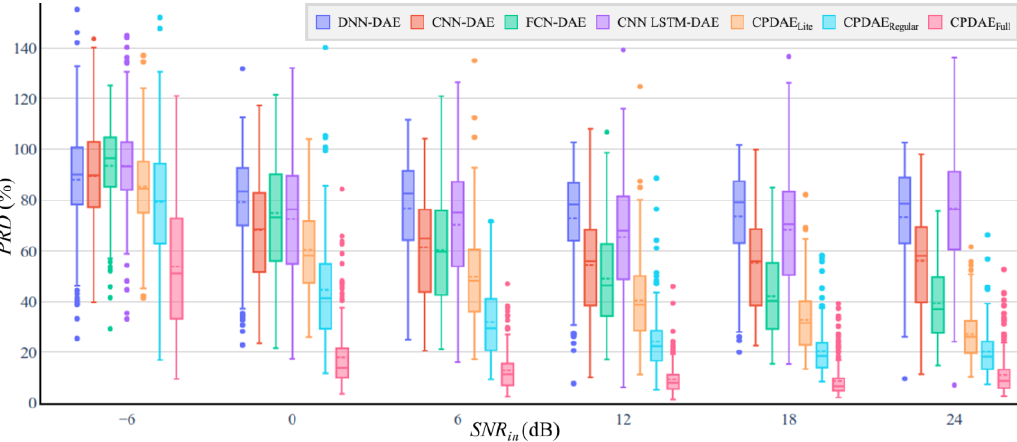
Figure 11. Box plots for SNR imp comparison of the denoising criteria of all of the evaluated methods under six SNR in for the testing phase of NSTDB; the box plots include outliers (dot), minimum, in- terquartile range, median, maximum, and average (dotted line).